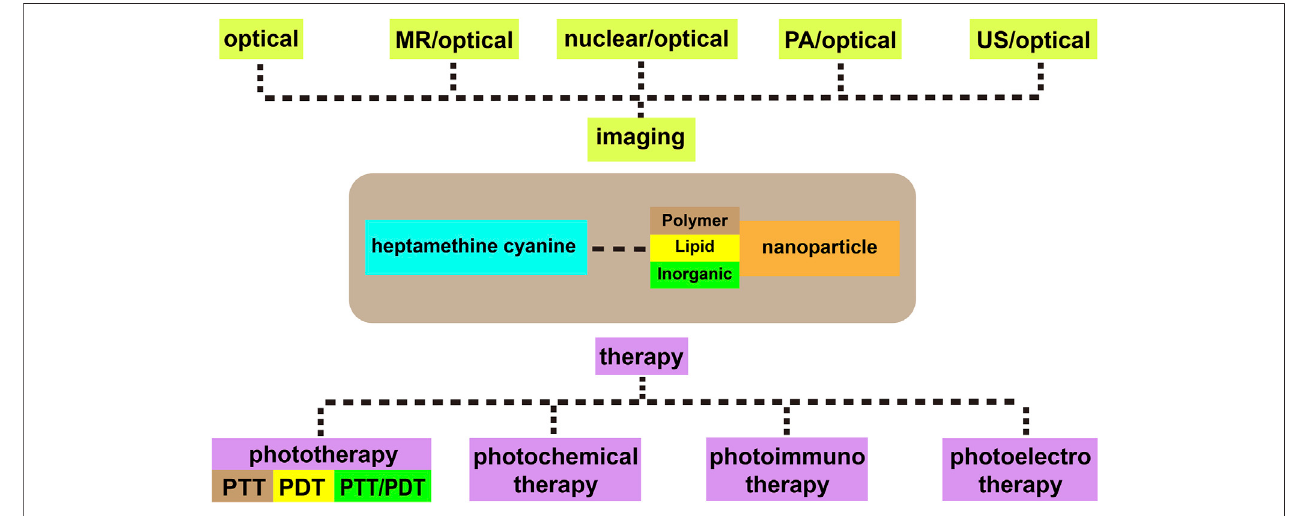
FIGURE 1 | Heptamethine cyanine – based application for cancer